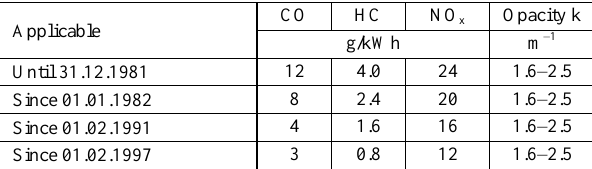
Table 1. Exhaust emission limit value according to ORE B13 [1]